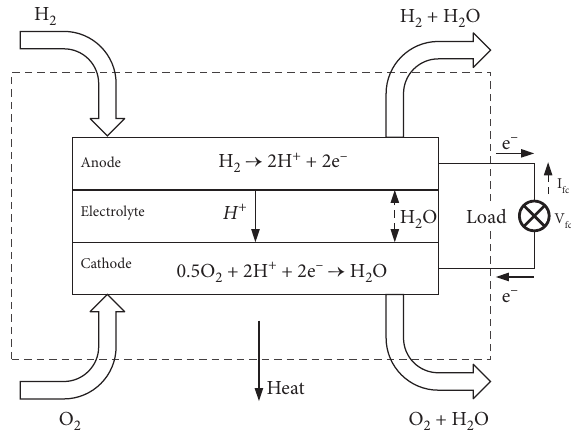
Figure 2: The operation principle of the PEMFC